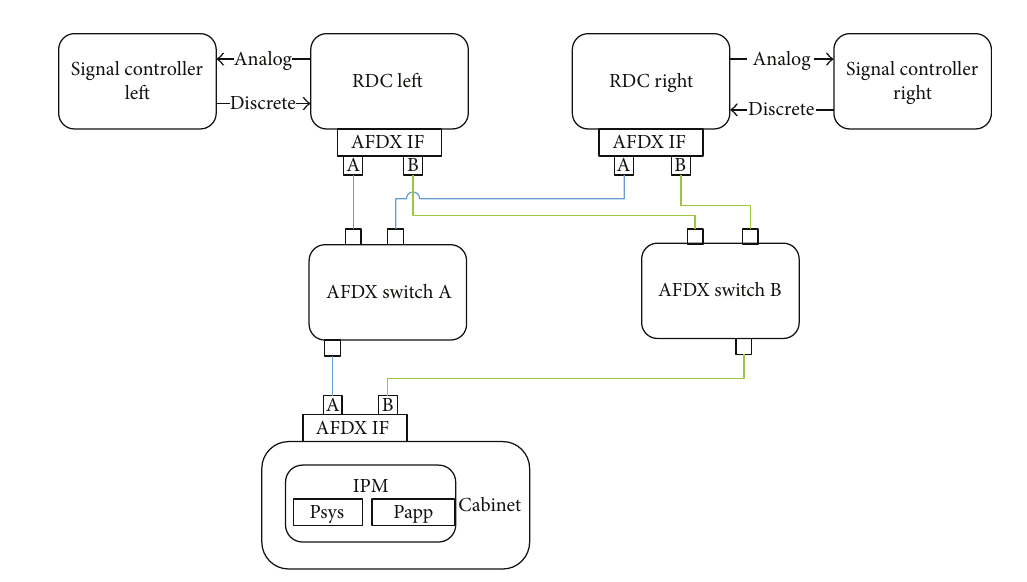
Figure 22: The resource architecture of water-and-waste system. Table 15: Schedule information of WAW